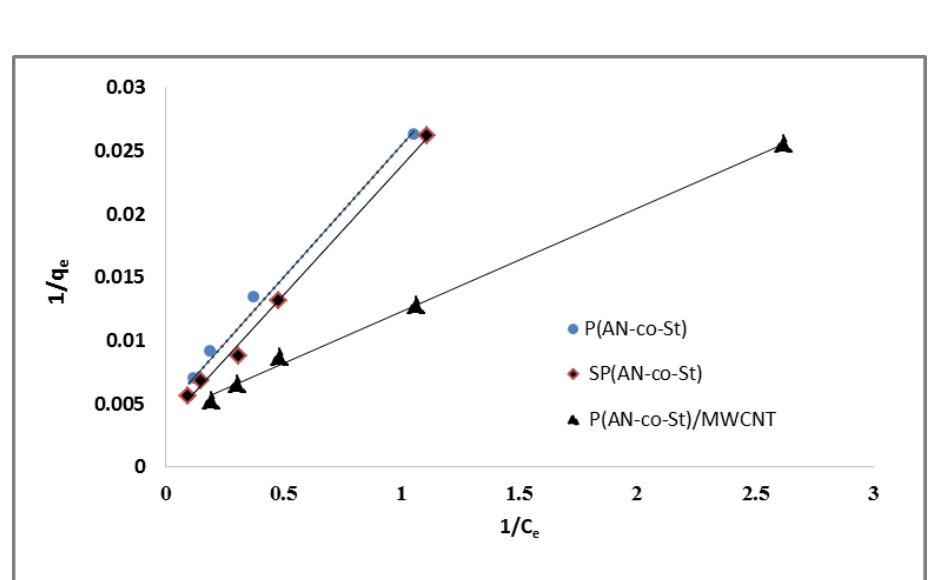
Figure 10. Langmuir plots for adsorption of MO onto different composites.